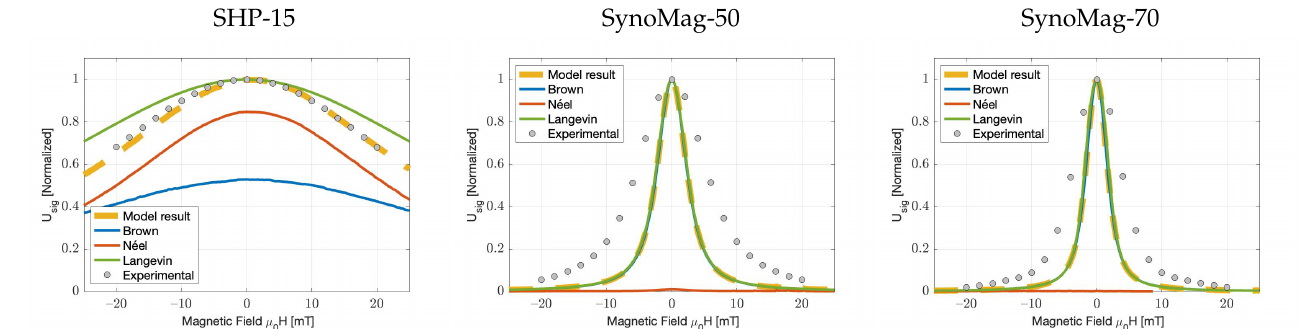
Figure 3. Particle response functions (experimental and simulated) for three particle-types under the application of a 2.5 kHz, 1.3 mT/ µ 0 AC field, α (cid:48) = 0.1, η = 1.0049 mPas, the particles’ characteristics can be found in Table 1. ( Left ): SHP-15, T: 298 K, bins: {10, 11,..., 14} nm. ( Middle ): Synomag ® -D50, T: 267K, bins: {20, 21, ..., 28} nm. ( Right ): Synomag ® -D70, T: 267K, bins: {22, 23,..., 36}